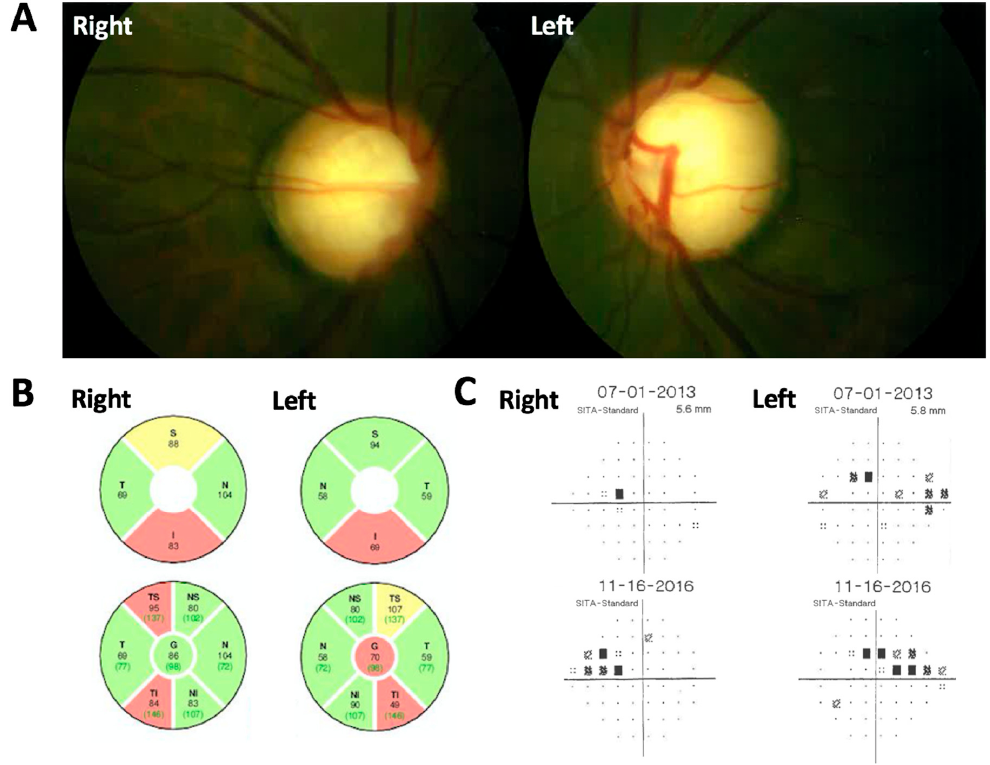
Figure 1. Proband ocular assessments. ( A ) Fundus photo of right and left eyes. ( B ) OCT-RNFL (ocular coherence tomography retinal nerve fiber layer) of both eyes. Key: Superior (S), Temporal (T), Nasal (N), Inferior (I). ( C ) Right and left nasal step visual field defects consistent with glaucomatous damage.